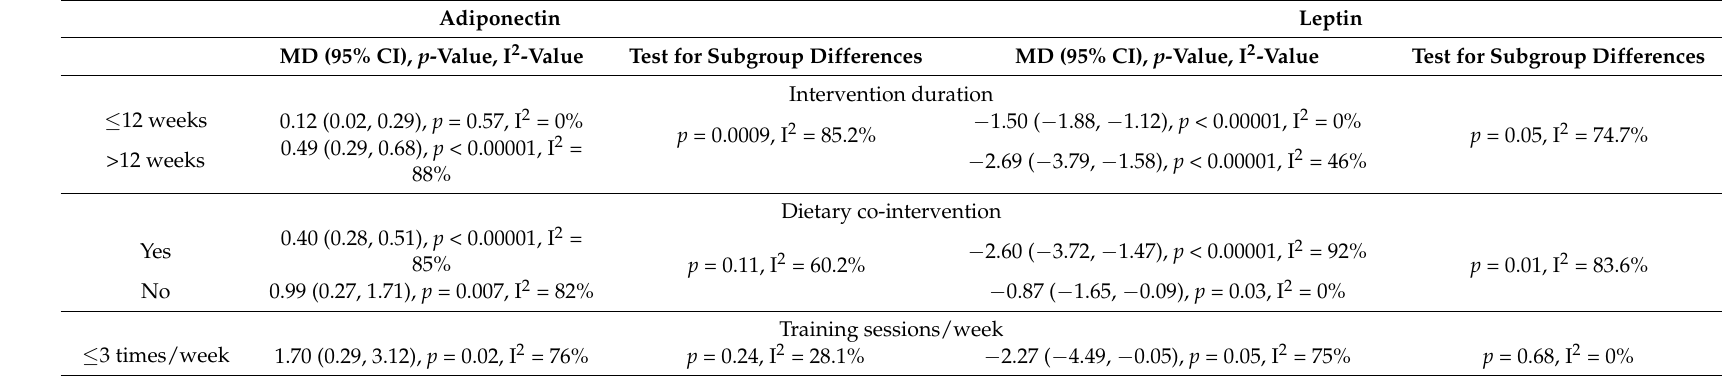
Table 2. Results of subgroup